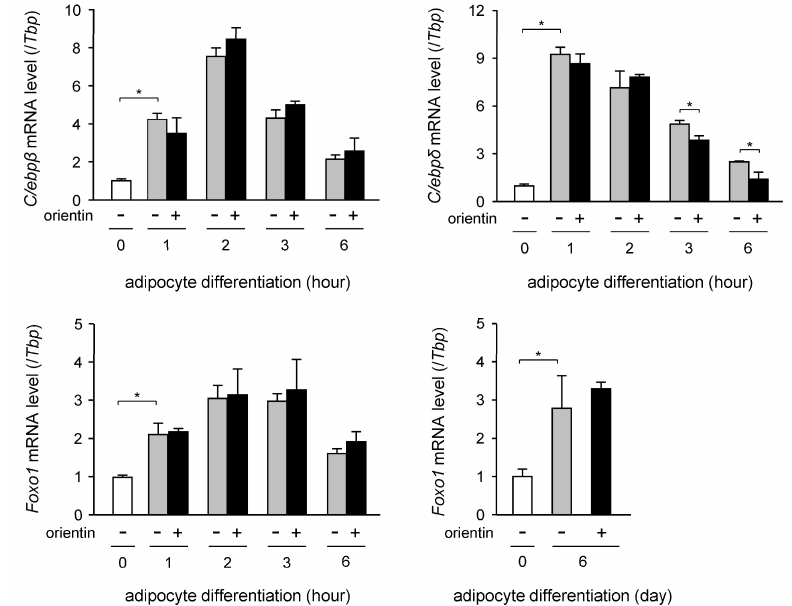
Figure 4. Expression profile of the C/ebp β , C/ebp δ , and Foxo1 genes in early stage of adipogenesis 3T3-L1 cells (white columns) were allowed to differentiate into adipocyte (differentiated cells: gray columns) for the indicated time (h:h) in medium containing orientin (50 µ M; black columns). The expression level of the C/ebp β , C/ebp δ , and Foxo1 genes was measured by qPCR. Data are the means ± S.D. from three experiments. * p < 0.01, as shown by the